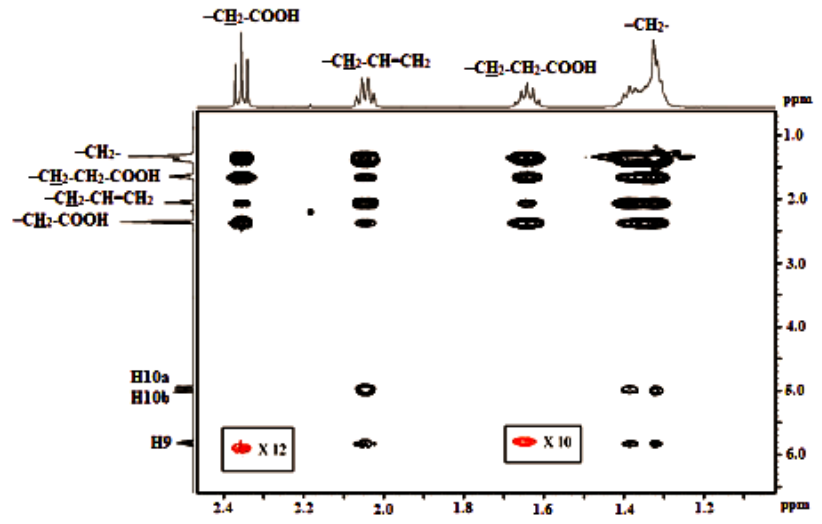
Figure 15. Selected region of 500 MHz 2D 1 H- 1 H TOCSY spectrum of caproleic acid in CDCl 3 (solution conditions the same as in Figure 14). Mixing time τ m = 100 ms, number of scans (ns) = 32, number of increments = 256, total experimental time = 5 h 19 min.